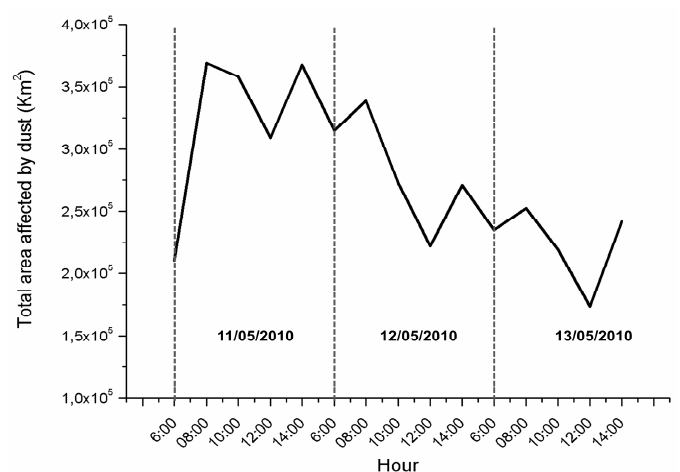
Figure 11. Temporal trend of the total area affected by dust determined by counting the number of dusty pixels in Figure 10 and assuming a mean SEVIRI pixel area of 15 km 2 . Note the general decreasing trend characterizing the analysed parameter after 11 May, along with the relative minimum systematically recorded at 12:00 UTC, indicating a slight reduction in the algorithm performance at that hour of the day.